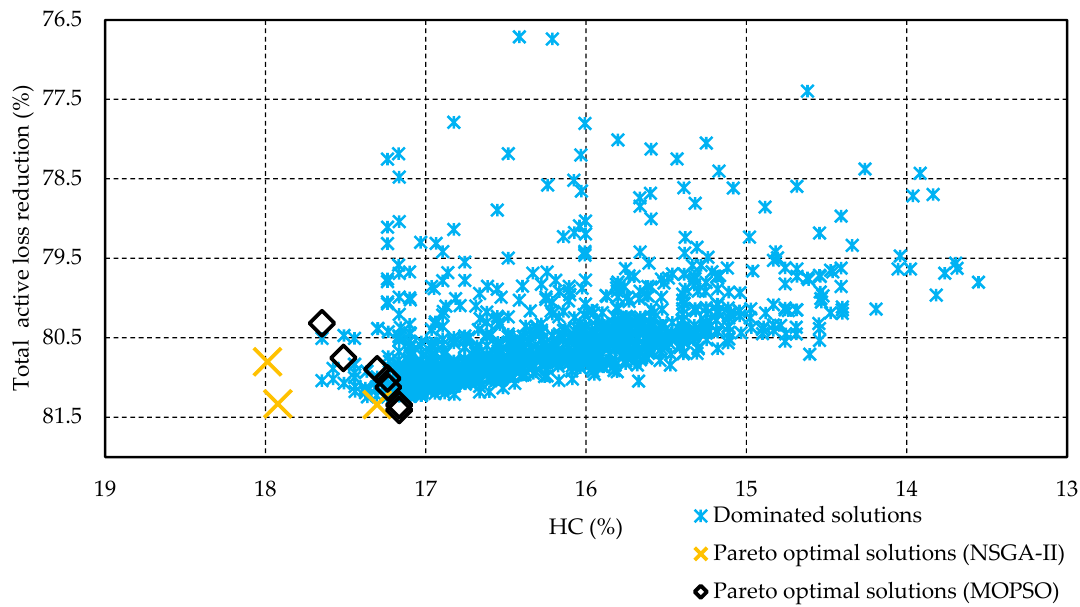
Figure 11. Pareto-front for the 83-node distribution network using NSGA-II and MOPSO.